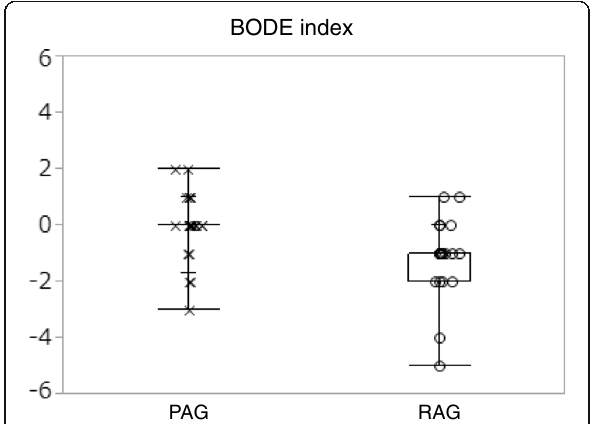
Fig. 1 Difference of body weight between baseline and after 12 weeks for each group is shown. The difference in the body weight in the RAG (2.5 [0.4]) was statistically significant compared with that in the PAG ( − 0.5 [1.4]) (mean difference 3.00, 95% CI 2.00 to 4.00 by ANCOVA). PAG;